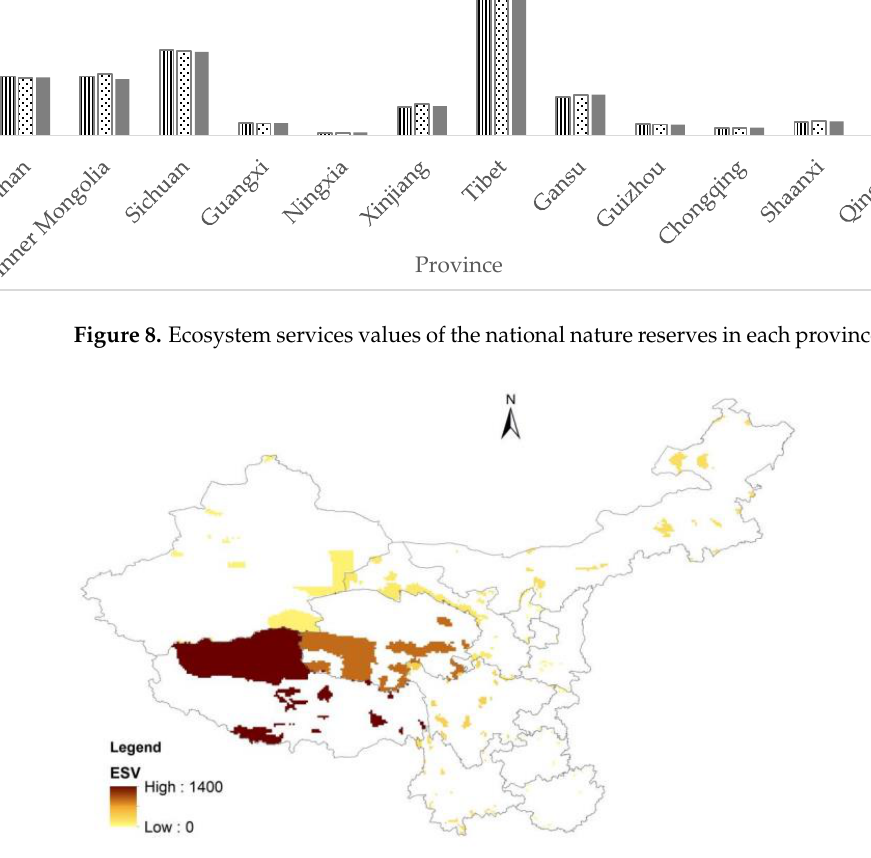
Figure 10. Ecosystem services values in the national nature reserves of western China in 2005. Figure 11. Ecosystem services values in the national nature reserves of western China in 2010.